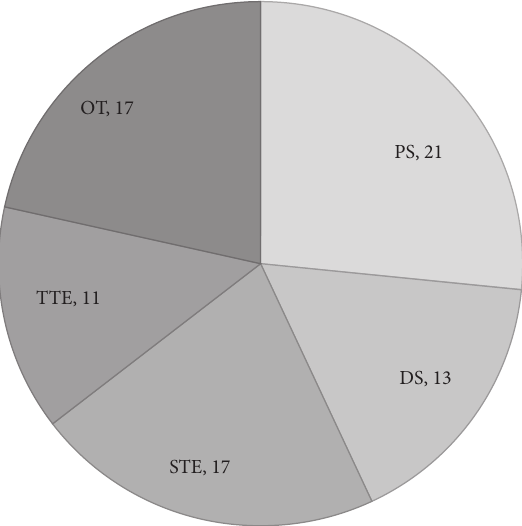
Figure 7: Cases of vertebral hemangioma with extraosseous exten- sion causing neurological deficits in previous reports. PS, percu- taneous sclerotherapy; DS, decompression surgery; STE, subtotal tumor excision; TTE, total tumor excision; OT, other